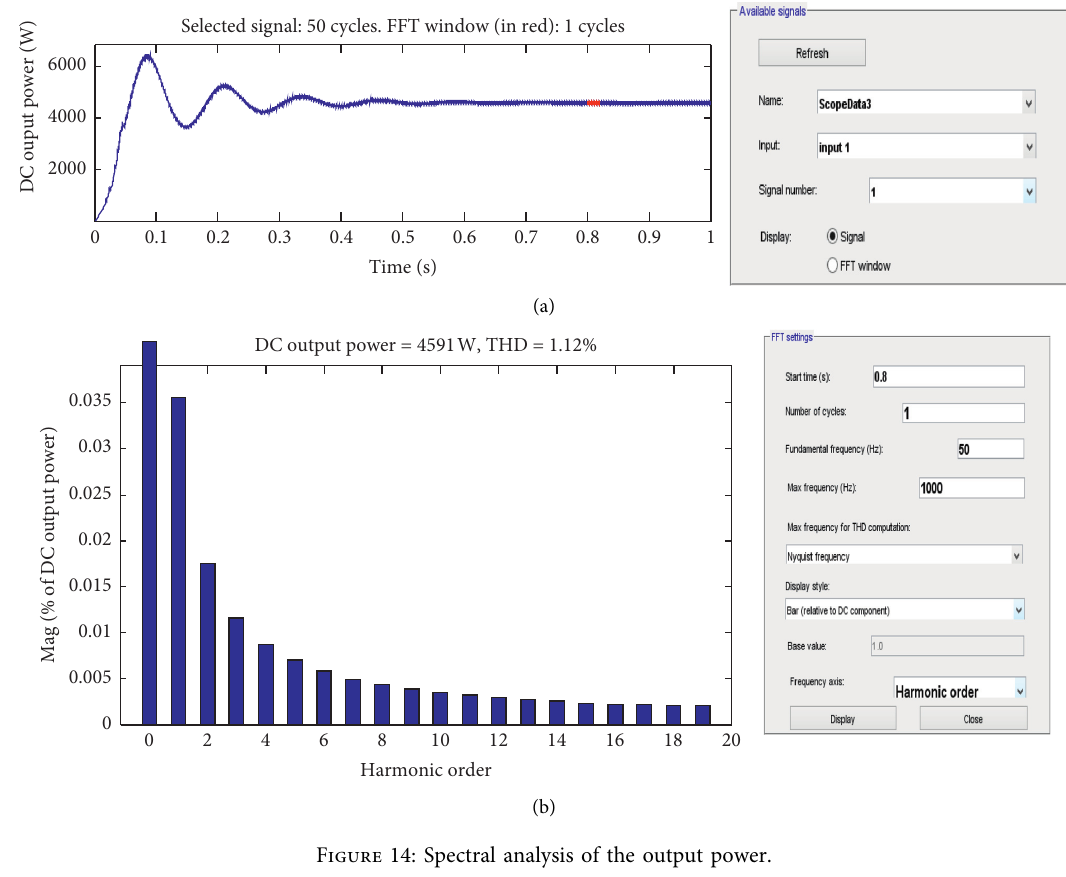
Figure 14: Spectral analysis of the output